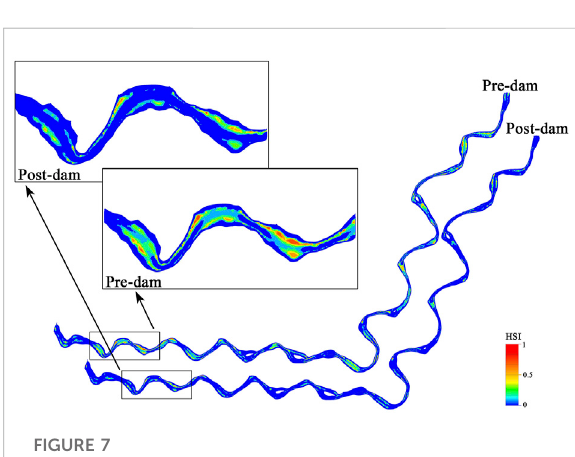
FIGURE 7 Habitatsuitabilityindexnumericaldistributionmapduringthe pre- and post-dam period at the Xiaolangdi Reservoir on the Yellow River,